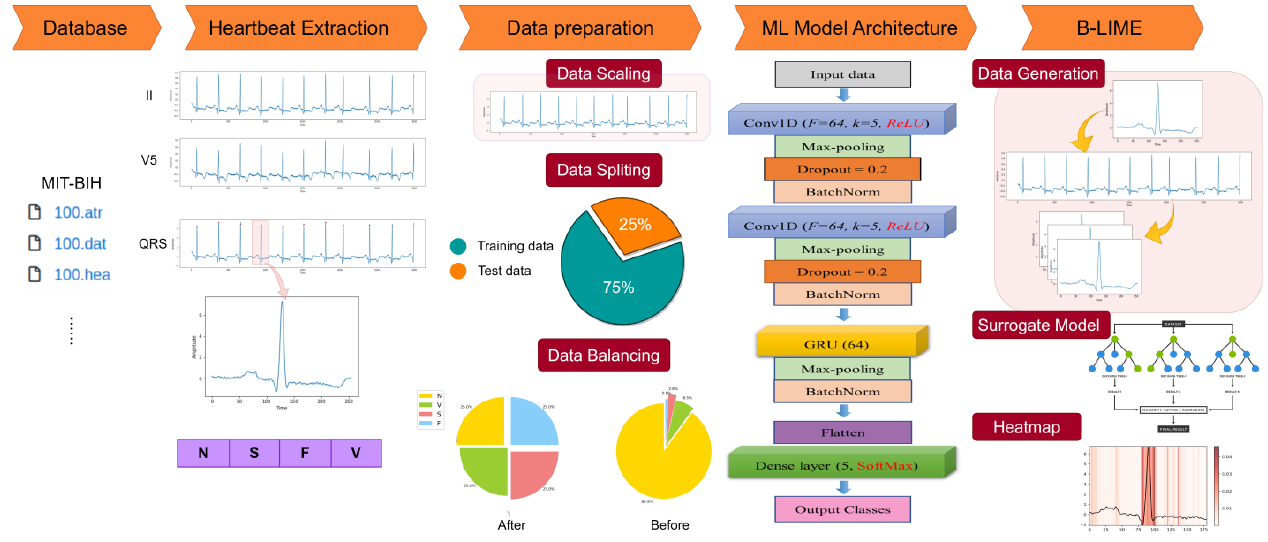
Figure 5. Schematic of the analysis pipeline.